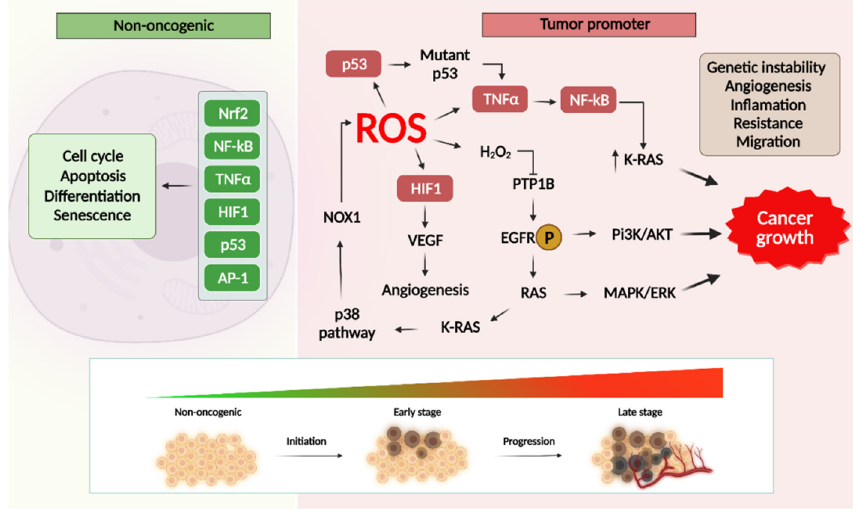
Figure 5. Activation of transcription factors and triggering of pro-oncogenic signaling pathways under the ROS action in the context of oxidative stress conditions. Transcription factors, such as AP-1, NF- κ B, HIF1, TNF α , p53, etc. normally regulate important processes of vital activity in the cell (differentiation, aging, and apoptosis). In the case of oxidative stress conditions, when the excessive accumulation of free radicals occurs, ROS activate certain signaling cascades including PI3K/AKT and RAS-MEK-ERK pathways, which leads to genetic cell instability, excessive angiogenesis, inflammation, and uncontrolled proliferation, as well as trigger the process of transformation of a healthy cell into a tumor.